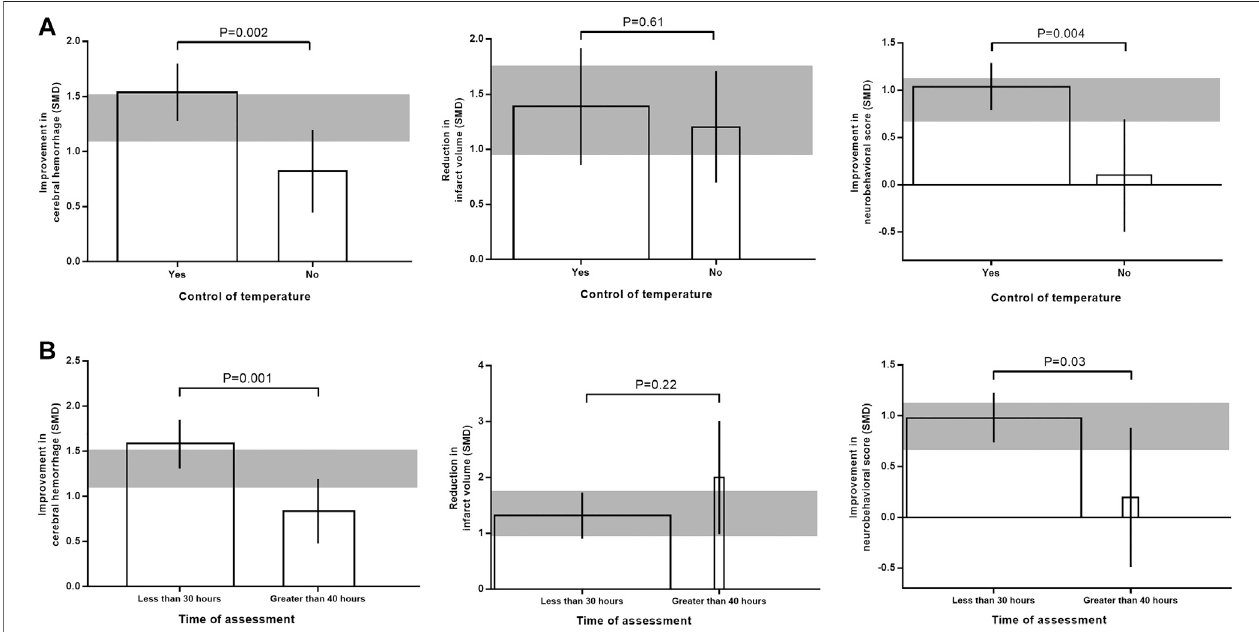
FIGURE 5| Effects of temperature control (A) and time of outcome assessment (B) on the ef fi cacy ofimmunomodulators in intracerebral hemorrhage, infarctsize, andneurobehavioralscore.Thewidthofeachbarrepresenttherelativenumberofanimalsinthatsubgroup.Theverticalerrorbarsrepresentthe95%con fi denceinterval for the individual estimates and the horizontal gray bars represent the 95% con fi dence interval of the pooled estimate of ef fi cacy.